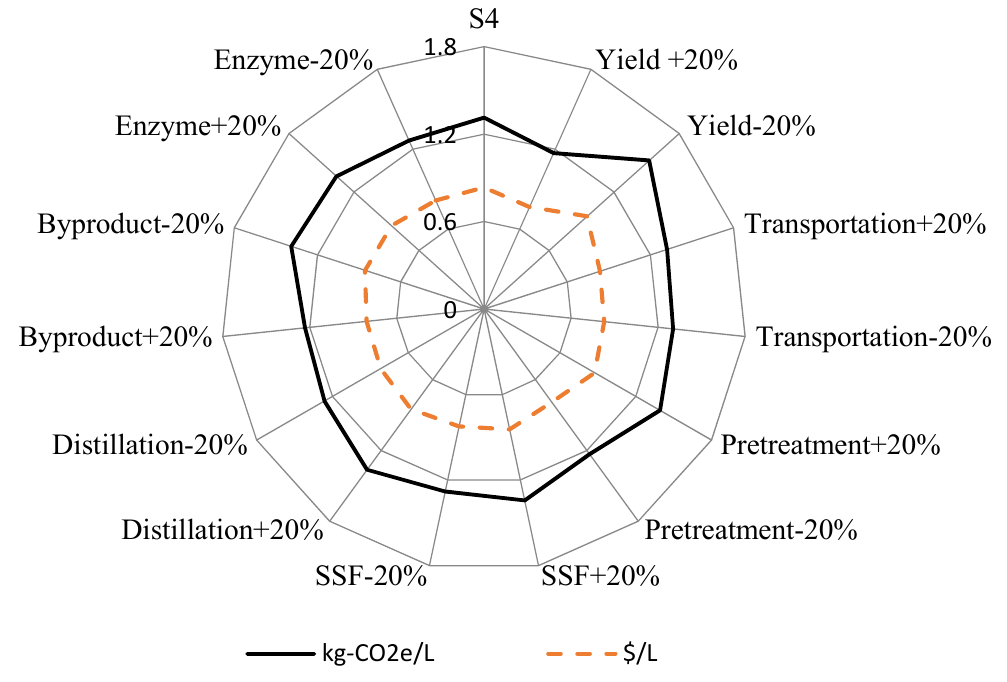
Figure 10. Effect of the variation of different parameters on net